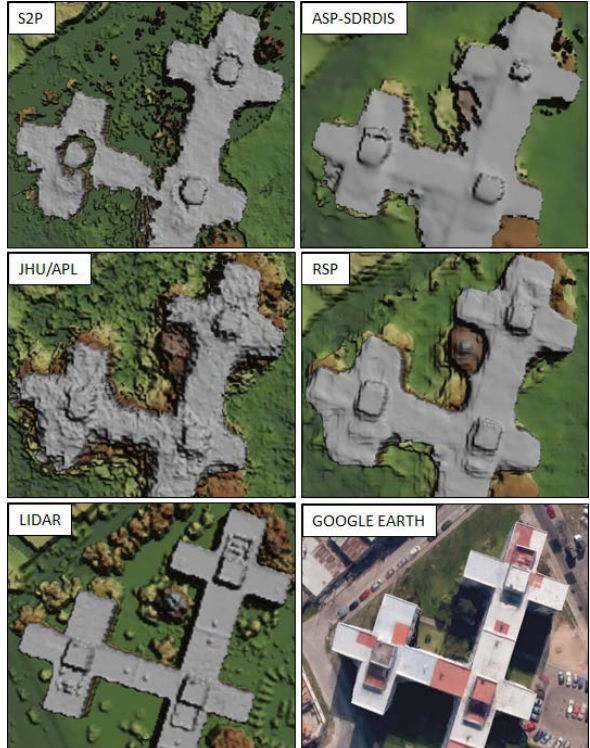
Figure 5 MVS and lidar point clouds are rendered as digital surface models and compared with Google Earth imagery. This close up view clearly shows some of the strengths and weaknesses of each of the MVS solutions.